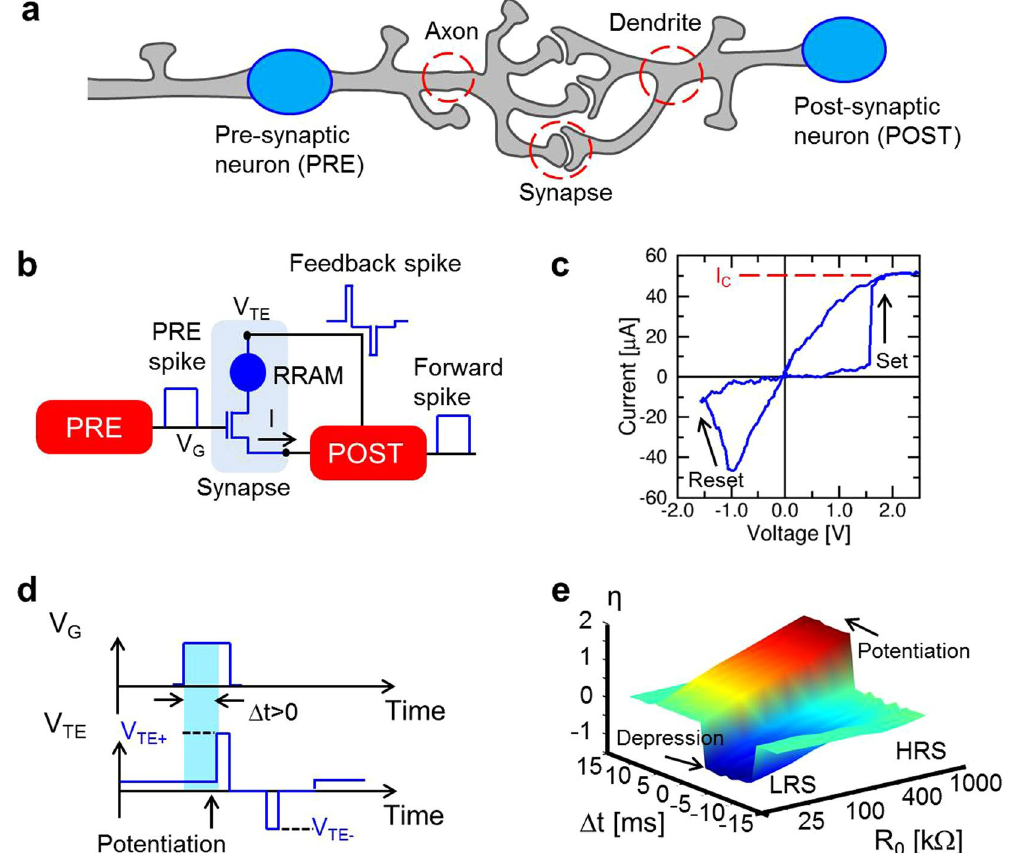
Figure 1. Synaptic device and characteristics. ( a ) Schematic structure of biological PRE, POST and synaptic connection between axon terminal and dendrite. ( b ) Schematic structure of the hardware PRE-synapse- POST unit: a PRE controls the FET gate of a 1T1R RRAM, while the POST receives the input current from the synaptic source and controls the synapse top electrode for inducing the synaptic current and stimulating potentiation/depression during the fire. ( c ) Measured I–V curve for a 1T1R RRAM synapse, showing set and reset transitions at positive and negative voltages, respectively, due to the bipolar operation of the HfO 2 RRAM. ( d ) Schematic voltage traces of the PRE spike (top) and POST fire (bottom) signals for the case of potentiation (0 < Δ t < 10 ms). ( e ) Experimental STDP characteristics, namely the measured conductance change η = R 0 /R as a function of the time delay between the PRE and POST spikes, for various initial synapse resistance values R 0 . Data indicate depression ( η < 1) for − 10 ms < Δ t < 0 and potentiation ( η > 1) for 0 < Δ t < 10 ms. Initial LRS involves only depression, while initial HRS shows only